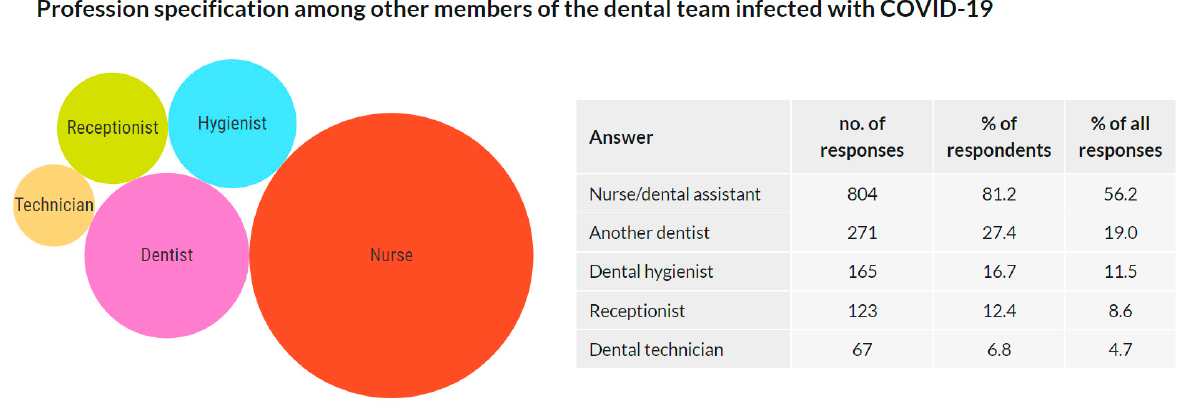
Figure 13. Profession specification among other members of the dental team infected with COVID-19.